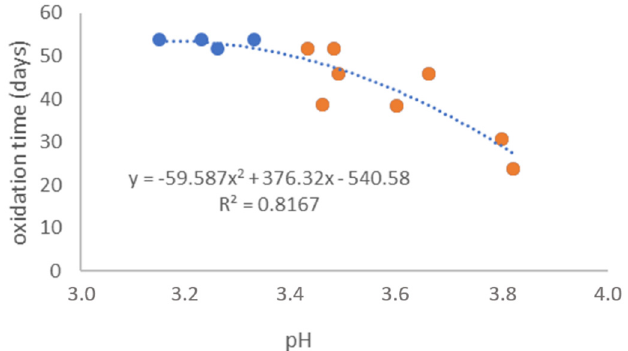
Figure 2. Correlation between oxidation time and pH. Blue dots correspond to white and rosé wines. The 8 reds are represented in orange.